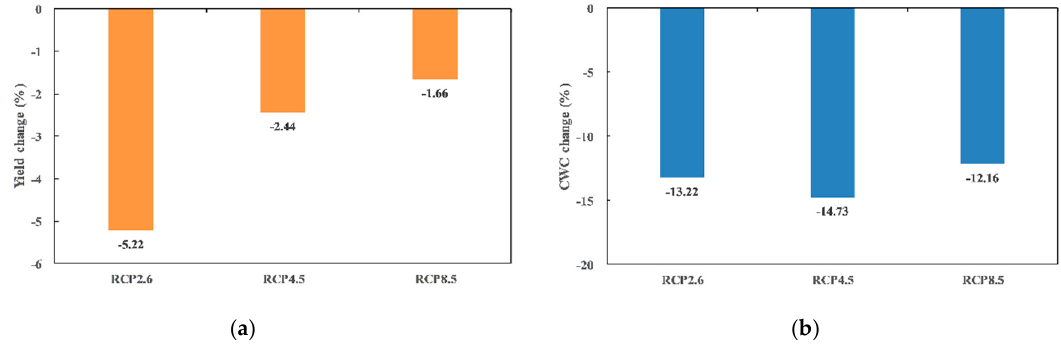
Figure 7. Changes of the mean annual ( a ) maize yield and ( b ) CWC in the Gaotai area under RCP2.6, RCP4.5, and RCP8.5.